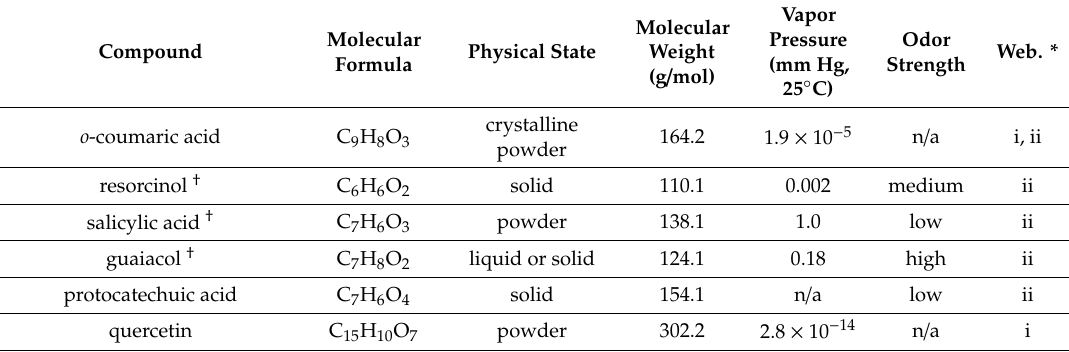
Table 2. List of VOCs and non-VOCs mentioned in this study with molecular weight, vapor pressure, and odor strength characteristics, regardless of predator taxa. In this review, VOCs † were characterized as having a vapor pressure greater than 0.001 mm Hg, 25 ◦